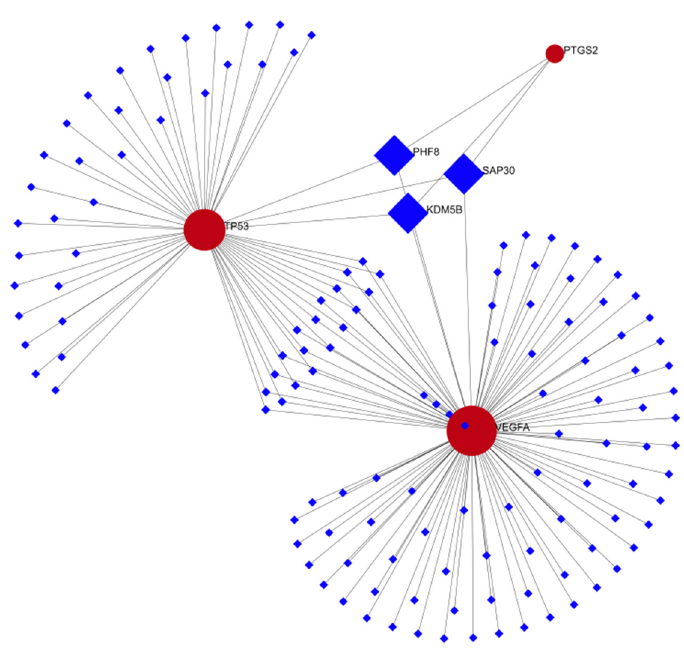
Figure 11. Interactions among 3 hub genes and transcription factors.